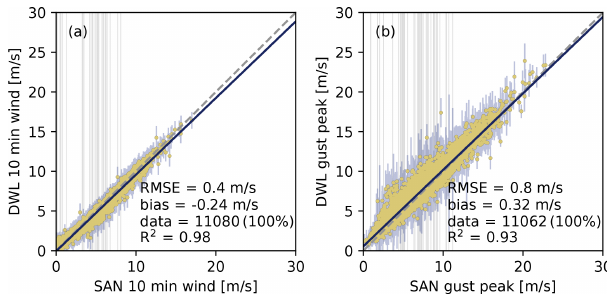
Figure 11. Scatterplots of sonic anemometer vs. DWL wind re- trieval during the period 1 June to 31 August 2020 at 90.3m. (a) Scatterplot of 10min mean horizontal wind from a sonic anemometer (SAN) versus the DWL operated in CSM2. (b) Scat- terplot of the SAN gust peak (3s in 10min) versus the DWL gust peaks (3.4s) operated in CSM2. The diagnostic numbers are ex- plained in Fig. 7. The estimated DWL standard deviation of the hor- izontal wind or gust peak is shown with vertical bars derived from the estimated covariance matrix with n ef = 12 (a) and n ef = 2 (b) ,